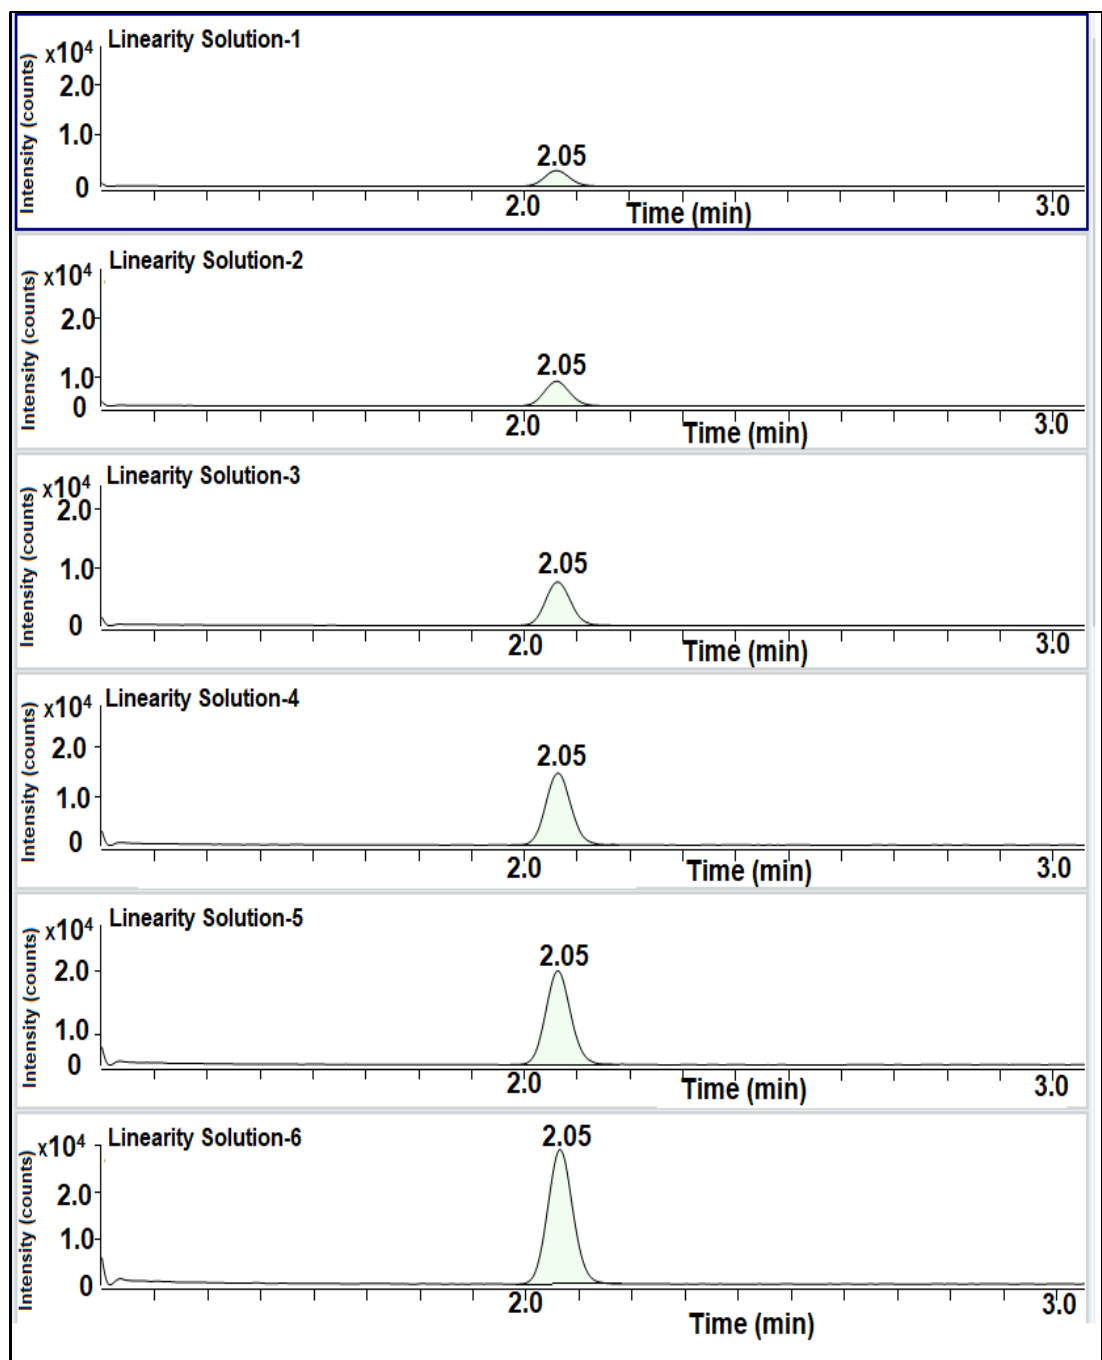
Figure 7. Linearity solution chromatogram.